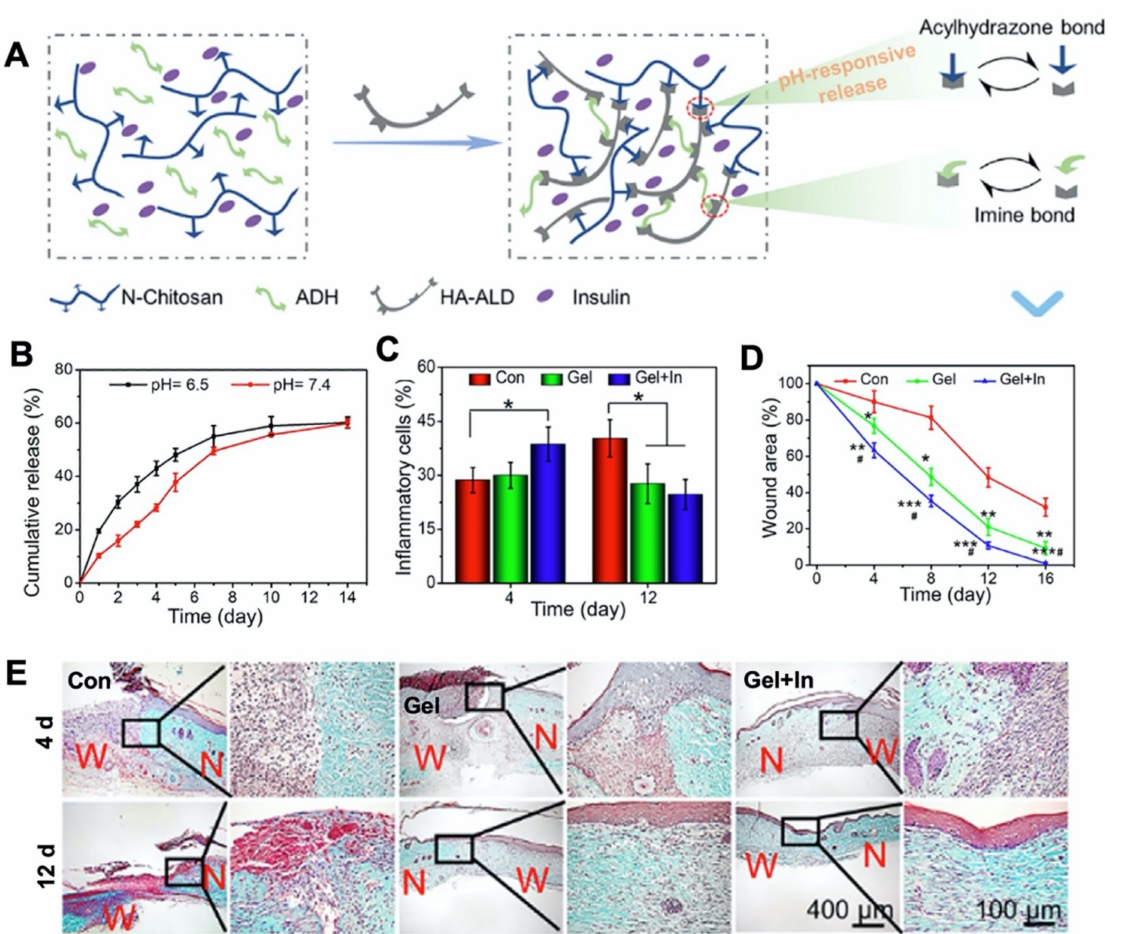
Figure 3. ( A ) Schematic representation for a pH-responsive chitosan based-hydrogel targeted for dia- betic foot ulcer treatment. A hybrid hydrogel (Gel) was constructed between N-carboxyethyl chitosan (N-chitosan), hyaluronic acid–aldehyde (HA-ALD), and adipic acid dihydrazide (ADH). Insulin was loaded into the polymer solution and reversible dynamic bonds were provided by acylhydrazone and imine bonds (Gel+In). pH responsive properties were achieved with acylhydrazone bonds. ( B ) pH-responsive release behavior of insulin for 14 days ( C ) Quantitative analysis of the number of inflammatory cells at 4 and 12 days after the operation (Tukey’s post-hoc analysis, * p < 0.05) ( D ) Quantitative analysis for wound area measured on days 0, 4, 8, and 12 (Tukey’s post-hoc analysis, * p < 0.05, ** p < 0.01, *** p < 0.001 compared with control group; # p < 0.05 compared with the hydrogel group) ( E ) Masson trichrome staining to show collagen deposition on days 4 and 12 after the application of Gel and Gel+In to full thickness foot skin wounds on diabetic rats (W: Wound area, N: Normal tissue). Reproduced with permission [128]. Copyright 2021